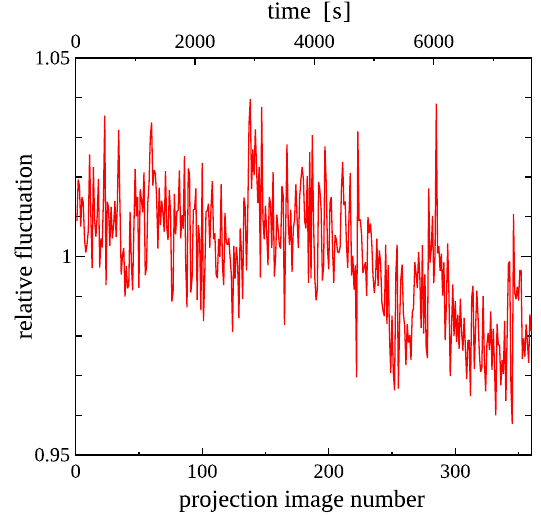
FIG. 6. The relative fluctuation of mean value of the pixel values in the rectangle area of the dashed red line in Fig. 4 after brightness correction.